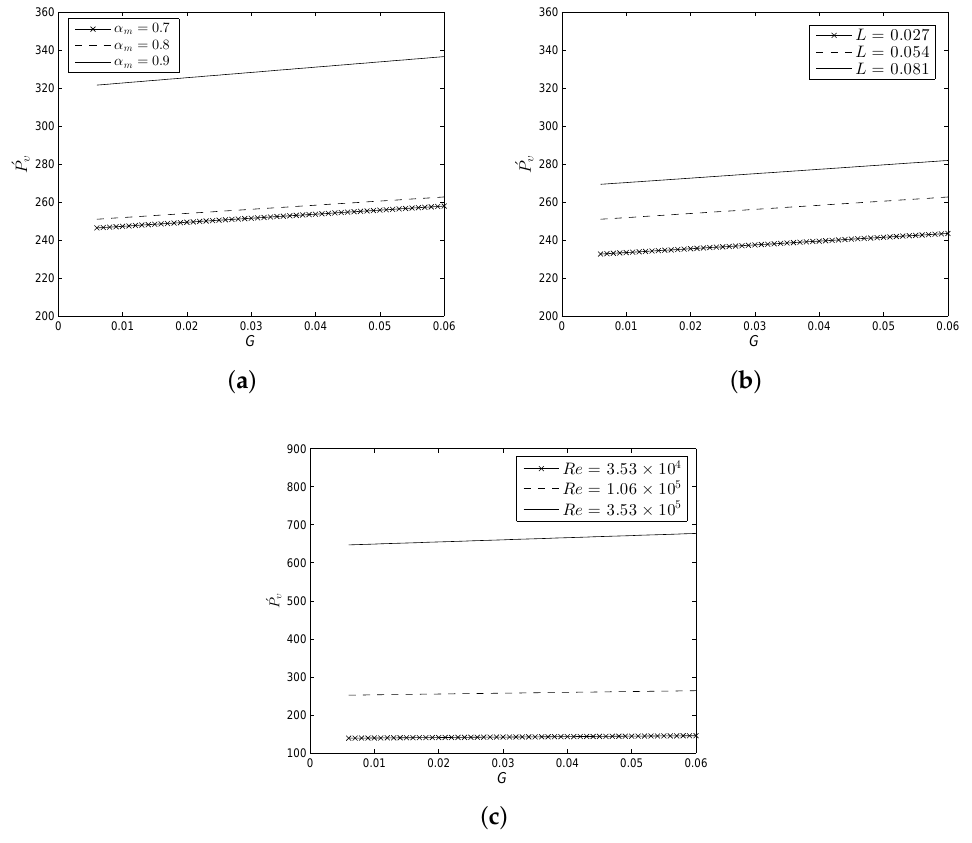
Figure 10. Variations of the dimensionless viscous power, ´ P v , versus G for the “magnet front” surface at different values of ( a ) magnet angle ratio; ( b ) magnet thickness ratio; and ( c ) rotational Reynolds